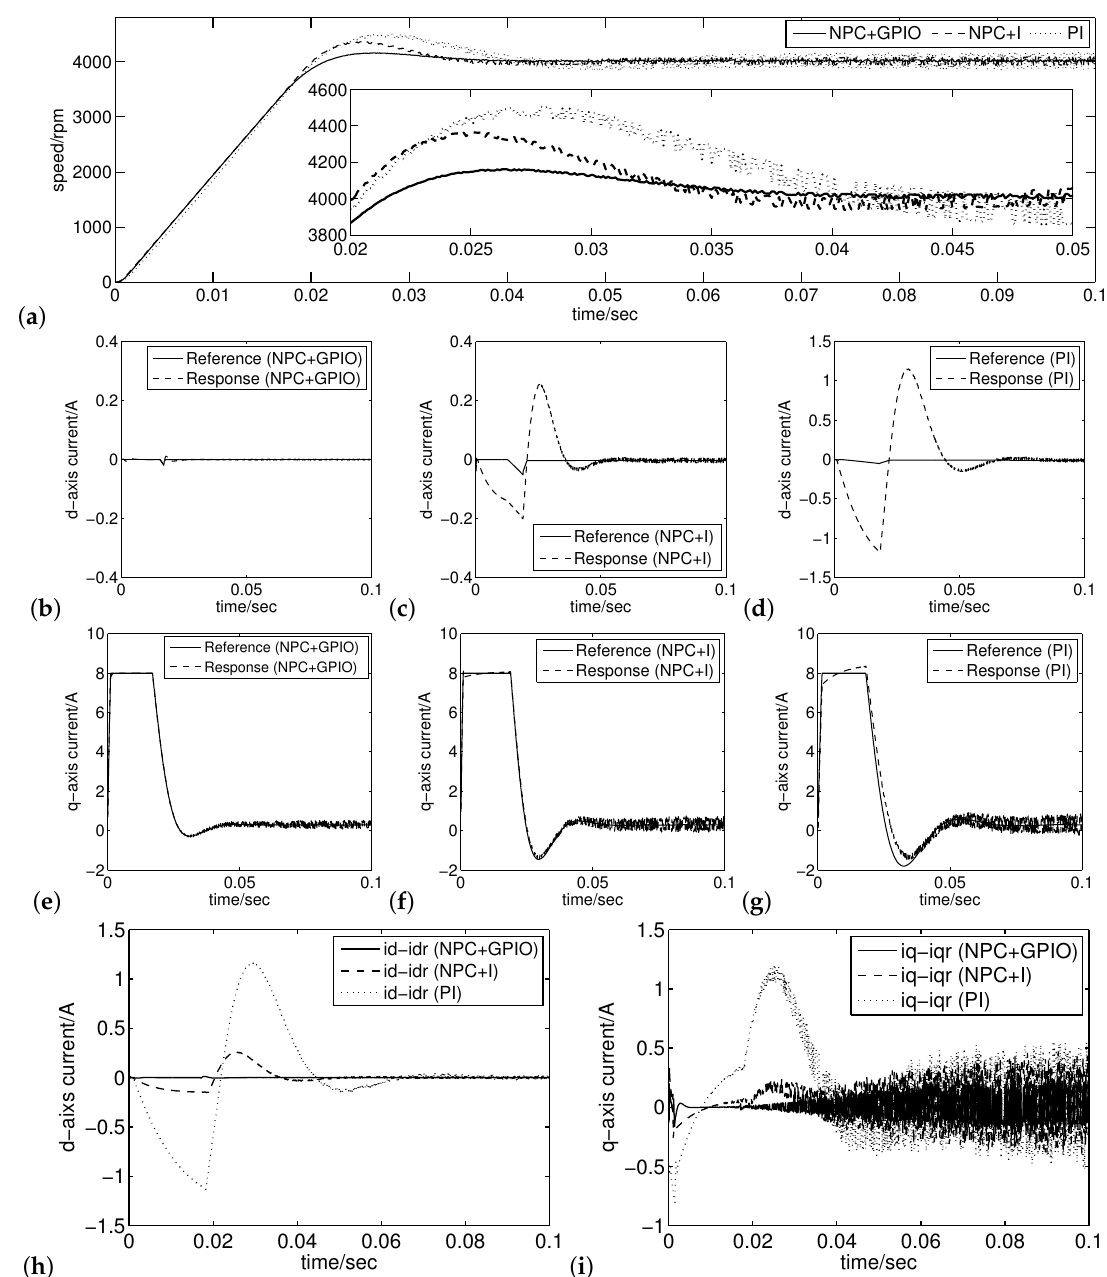
Figure 8. Speed and current responses with operation speed at 4000 rpm under the same speed controller (PI) and the different current controllers (the proposed controller (NPC + GPIO), the integral controller (NPC + I) and the improved PI controller): ( a ) speed responses; ( b ) d-axis current response under the proposed controller; ( c ) d-axis current response under the integral controller; ( d ) d-axis current response under the PI controller; ( e ) q-axis current response under the proposed controller; ( f ) q-axis current response under the integral controller; ( g ) q-axis current response under the PI controller; ( h ) d-axis current-tracking errors under the different current controllers (the d-axis response current (id) minus the d-axis reference current (idr)); ( i ) q-axis current-tracking errors under the different current controllers (the q-axis response current (iq) minus the q-axis reference current